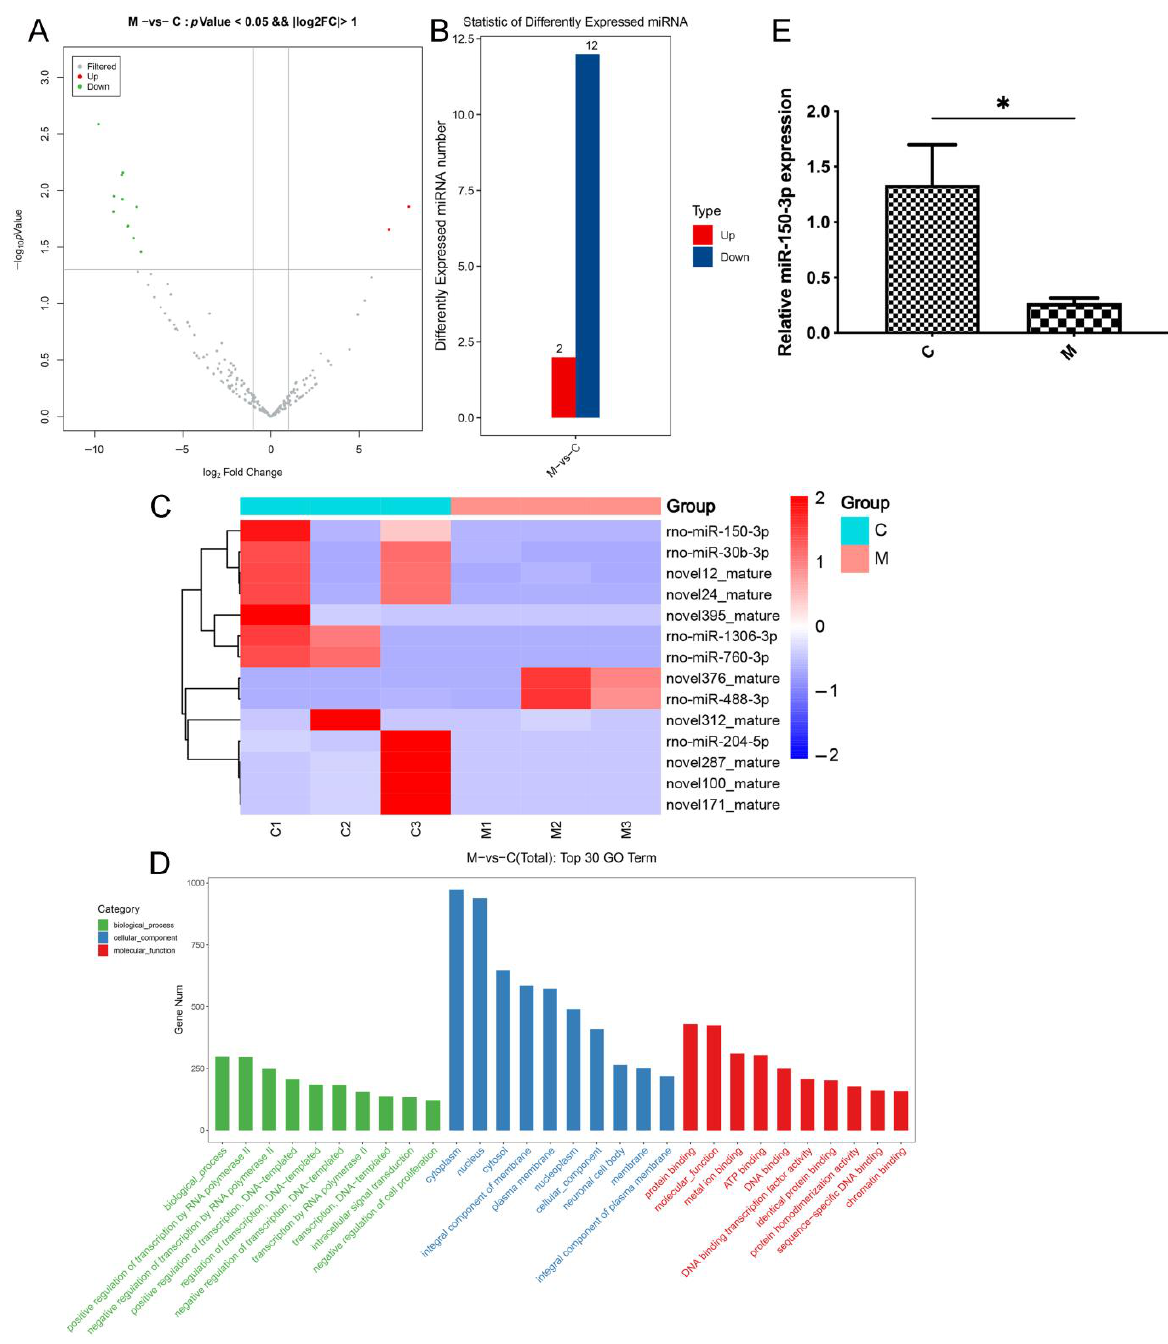
Figure 3. RNA sequencing analyzed DE miRNAs in EVs between the control (C) and model (M) groups. ( A ) Volcano plot of differentially present miRNAs. Gray indicates the miRNAs present at similar levels between the two groups; red indicates the significantly higher presence of miRNAs; and green indicates the significantly lower presence of miRNAs; X-axis is log 2 Fold Change, and Y-axis is − log 10 p -value. p < 0.05, |log 2 fold change| > 2. ( B ) Fourteen miRNAs were significantly differentially depicted, including twelve upregulated and two downregulated miRNAs. ( C ) Heatmap of the DE miRNAs. Red and blue indicate high and low levels, respectively. ( D ) Gene ontology analyses were performed. ( E ) qPCR validation of the miR-150-3p enrichment in the EVs. Three independent experiments indicate the data as mean ± SEM ( n = 3). * p <